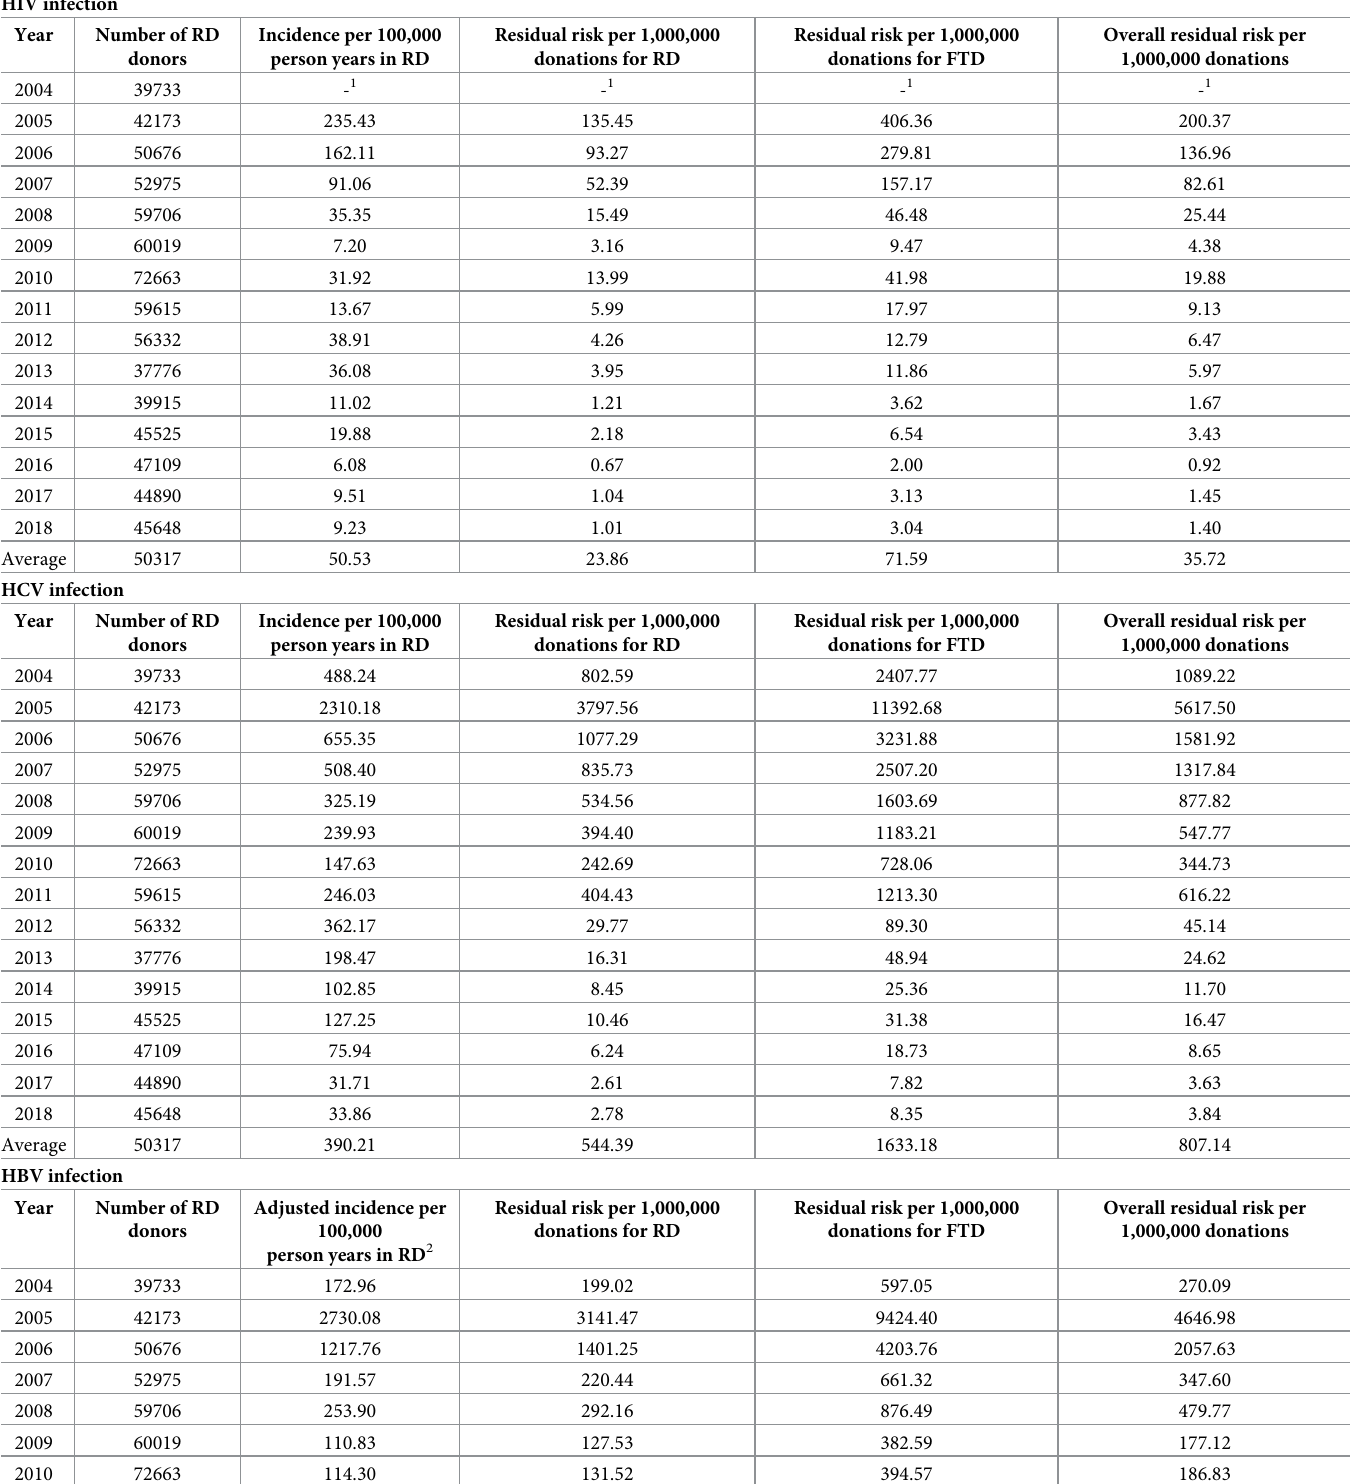
Table 3. Annual incidence rates in donors and residual risk of HIV, HCV and HBV transmission. HIV